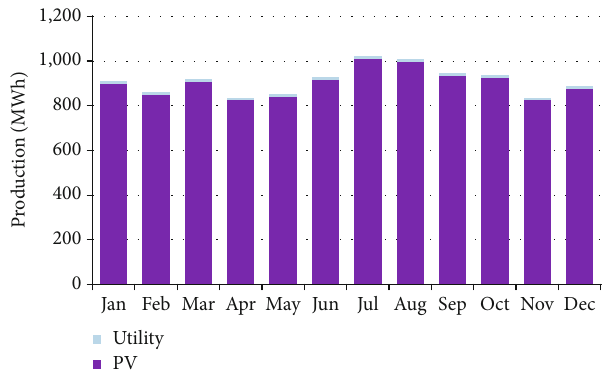
Figure 10: Utility and the solar PV microgrid electricity